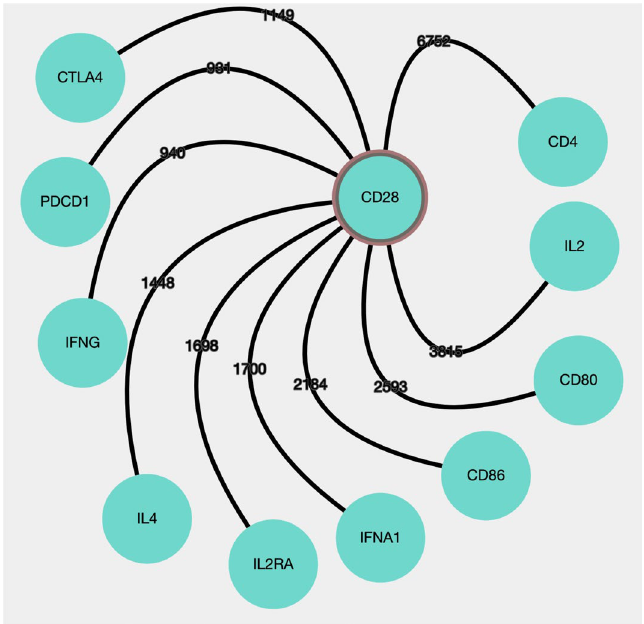
Figure 1. Illustrates the efficacy of DES-Tcell to retrieve established or strong associations. Only the top 10 associations of genes/proteins linked to CD28 as found in the DES-Tcell KB are shown. The nodes represent concepts from the “immunology related (various)” dictionary. Depending on the co-occurrence frequency, the color of edges will range from black (strong association) to grey (weaker association), and the number on each edge represents the number of documents that link the potentially associated